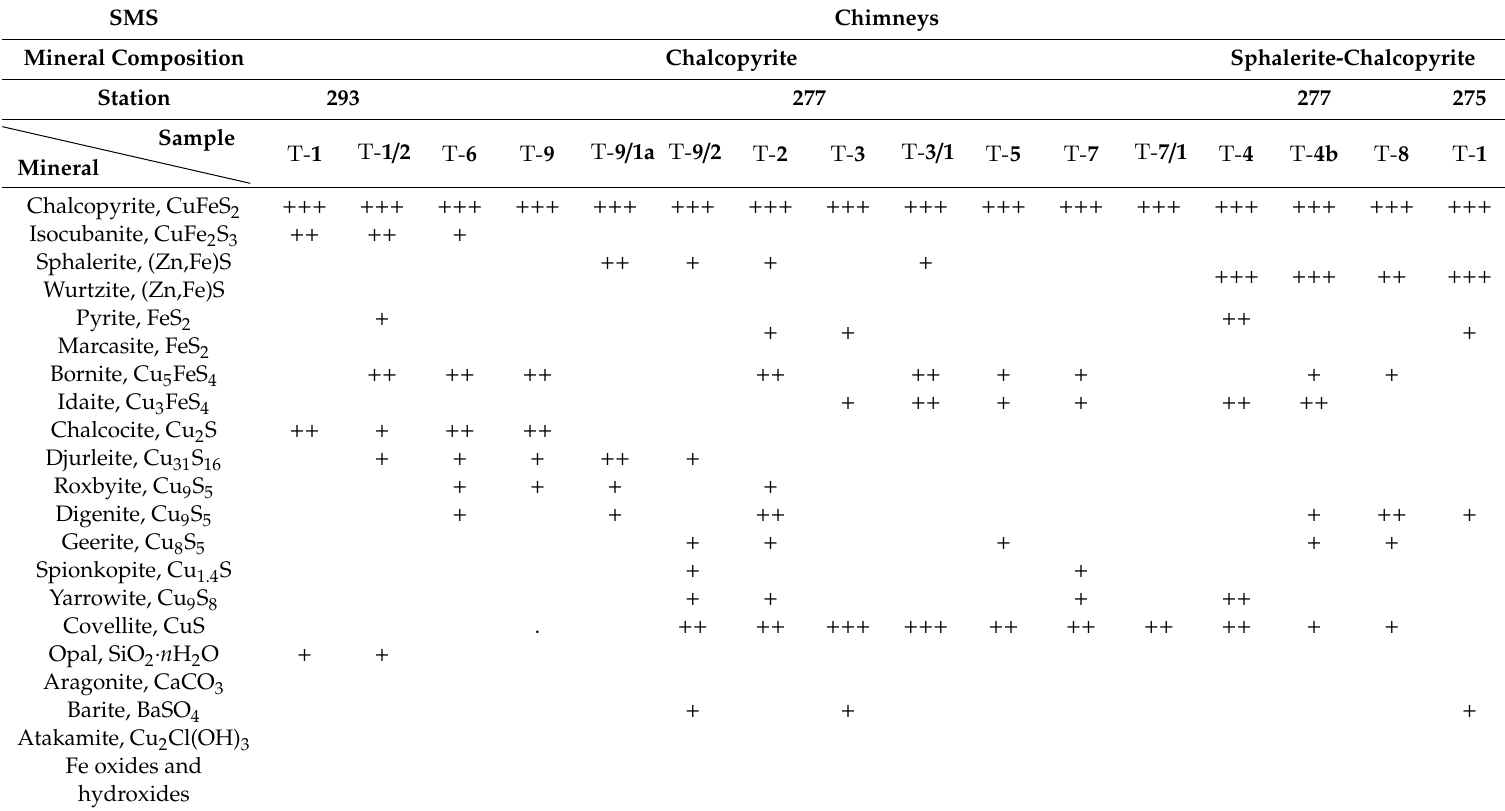
Table 2. Major and minor minerals of sulphide samples from Semyenov-2 hydrothermal